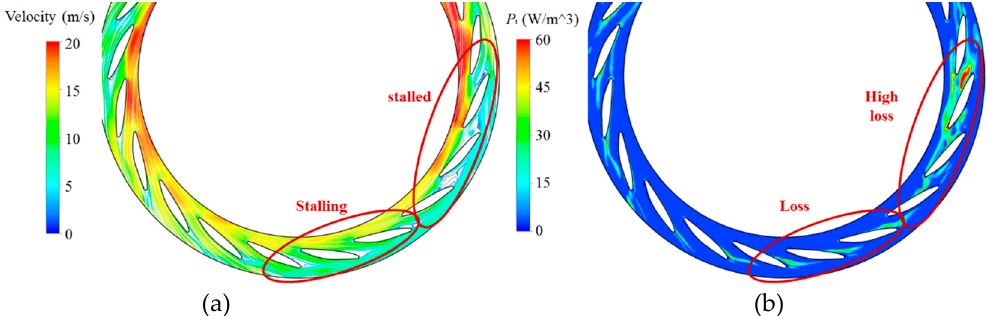
Figure 20. Instantaneous distributions of ( a ) streamlines and ( b ) turbulent kinetic energy dissipation in guide vane channels at condition III.